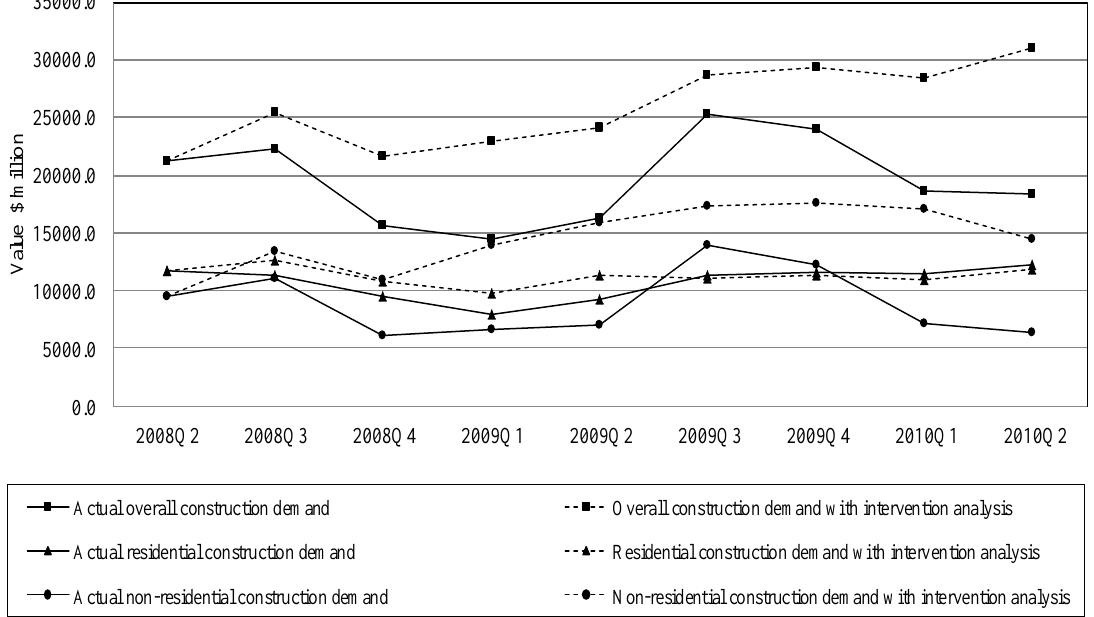
Figure 2 Comparison of different types of actual construction demand and